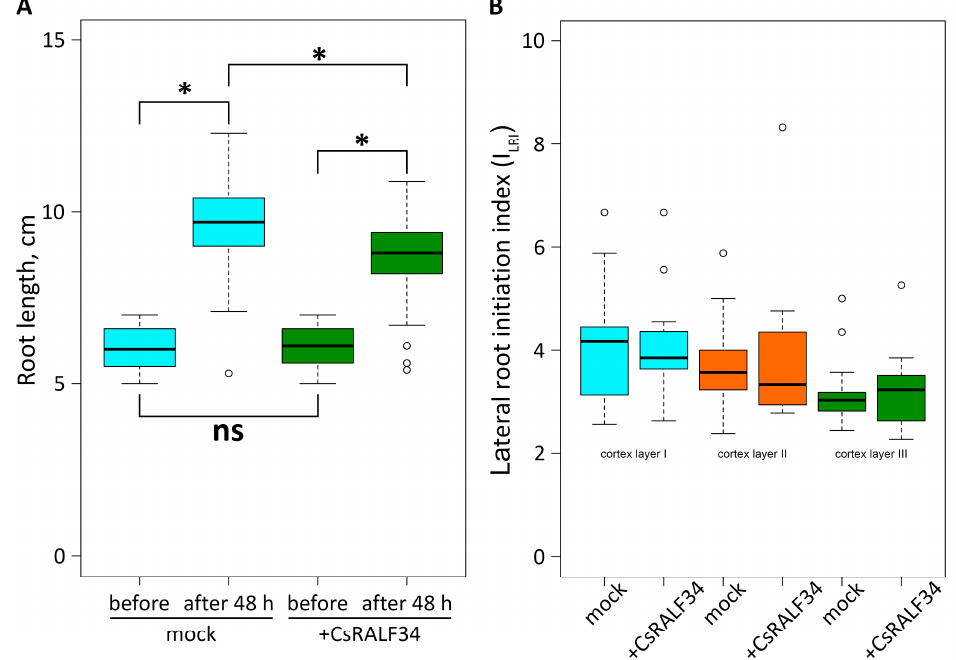
Figure 2. Comparison of Cucumis sativus roots treated with 2 µ M synthetic Cs RALF34 peptide for 48 h. ( A ) Comparison of average root length between the control group (mock, n = 100) and treated roots ( +Cs RALF34, n = 100). Statistical analysis using Wilcoxon’s signed-rank test showed no significant differences in root length before treatment (ns) and significant differences in root length (*, p < 0.001) after treatment. ( B ) Comparison of the Lateral Root Initiation Index in three outer cortical layers. Statistical analysis using Wilcoxon’s signed-rank test showed no signi fi cant di ff erences ( p > 0.05) between the I LRI values of control roots (mock, n = 14) and treated roots (+ Cs RALF34; n = 10).